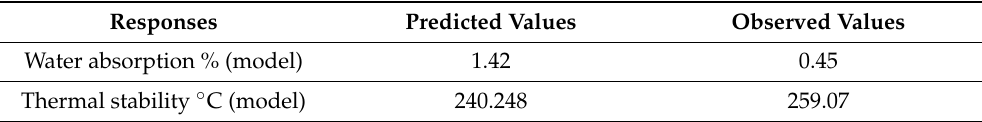
Table 6. Predicted and observed values for water absorption and thermal stability of bioplastic films.